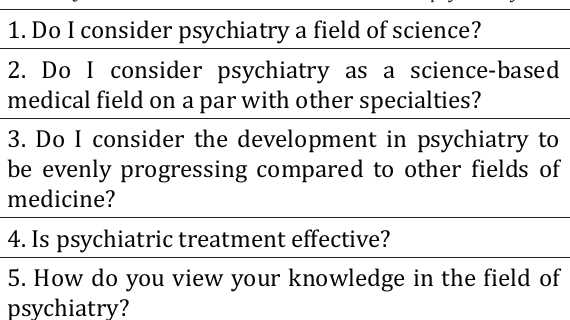
Table 4. Questions that measured attitudes toward